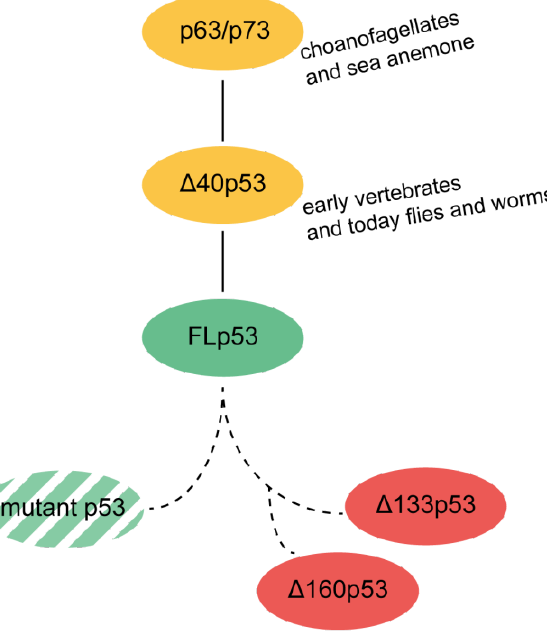
Figure 3. Possible evolutionary pathway of the p53 protein as a germline surveillance factor and its isoforms. p63/p73 genes evolved first in the early multicellular organisms from p53, similar to how the ∆ 40p53 isoform evolved in primitive vertebrates. From this, FLp53 evolved in higher organisms. From FLp53, various mutant p53 isoforms as well as the N-terminal truncated isoforms ∆ 133p53 and ∆ 160p53 developed.